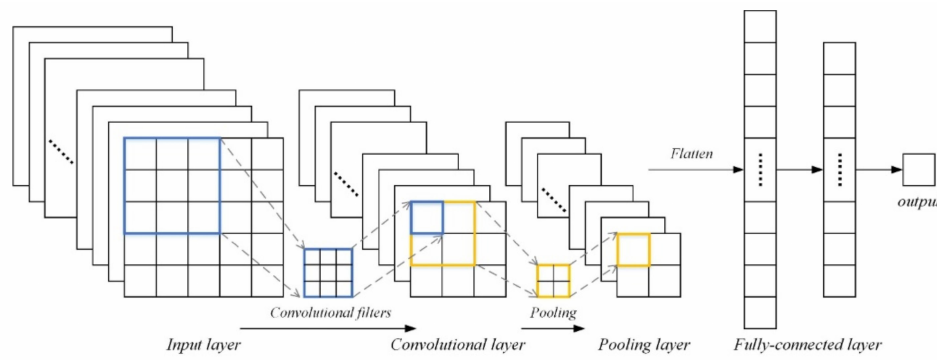
Figure 3. An example of the structure of a convolutional neural network (CNN) model.